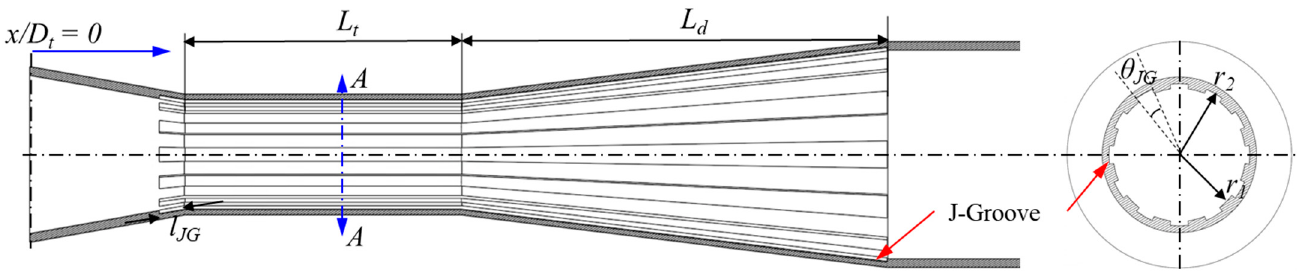
Figure 4. Schematic view of J-Groove shape parameters in annular jet pump model.